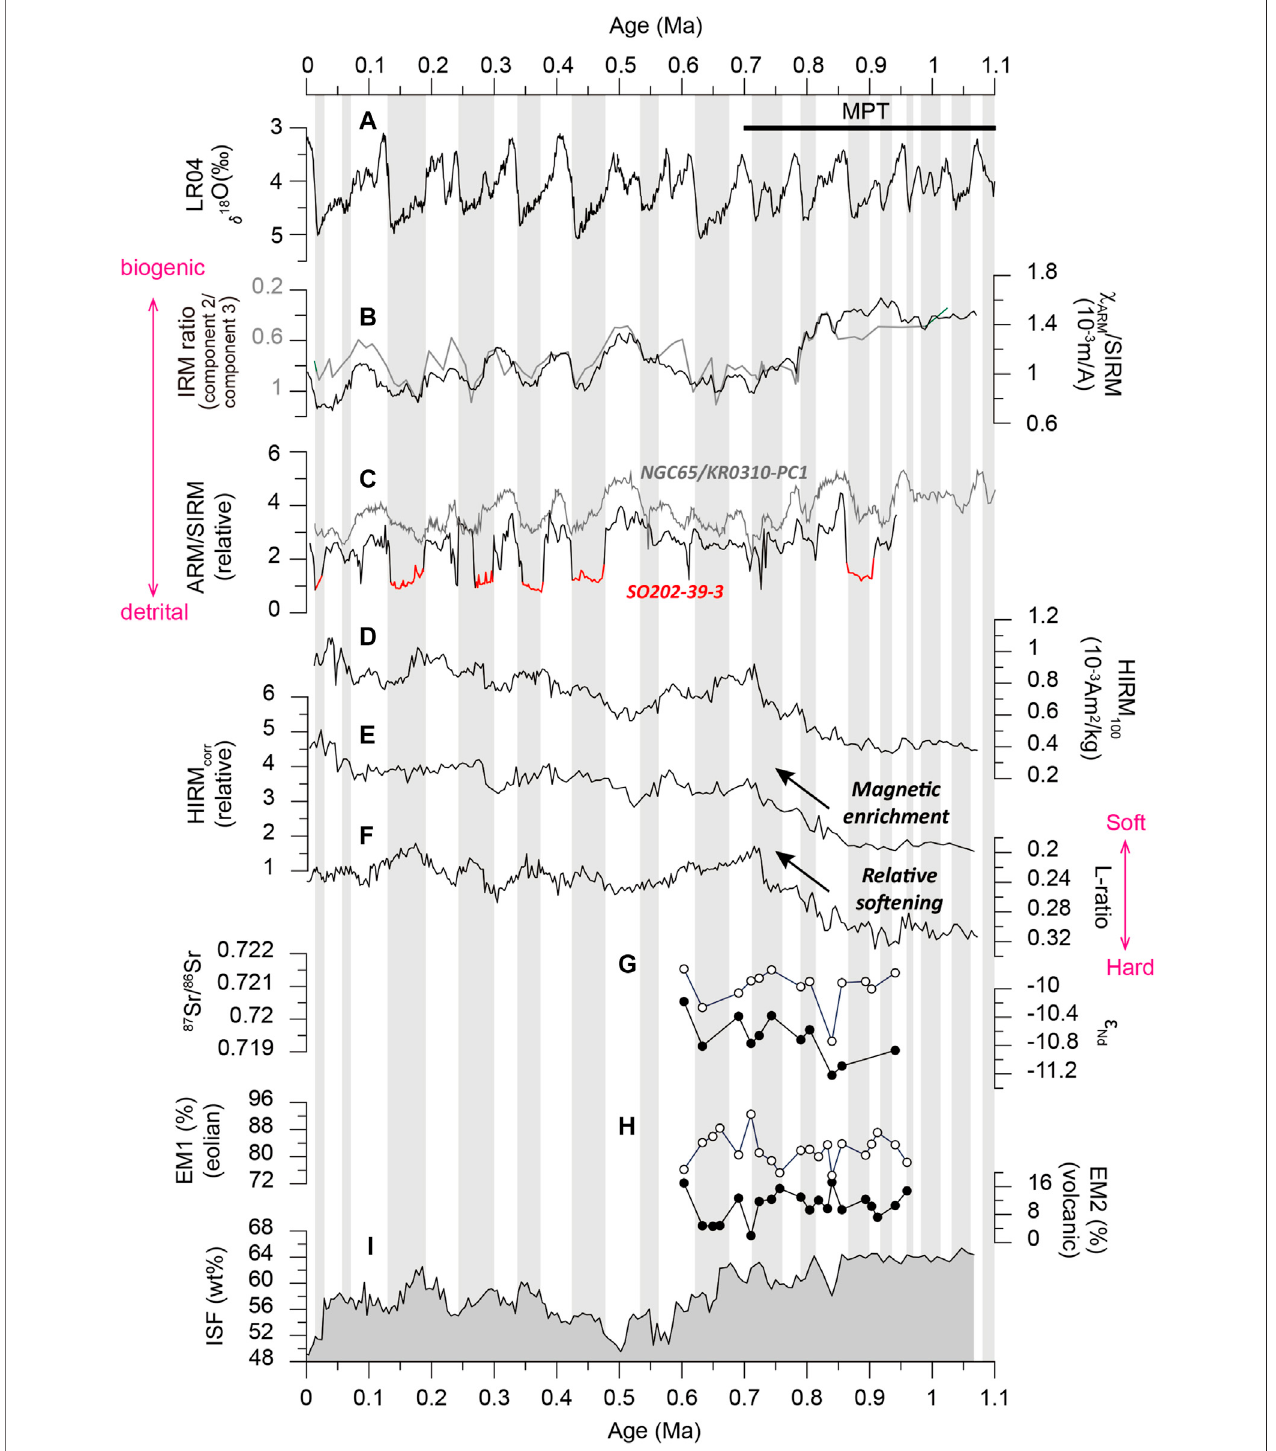
FIGURE5| Temporalvariationsofglobaloxygenisotopestack,magneticandgeochemicalcompositionsofNPGP1401-2Aandreferencecores. (A) LR04(Lisiecki andRaymo,2005); (B) RatiosofanhystereticremanentsusceptibilitytoSIRM( χ ARM /SIRM)(Shinetal.,2019)andIRMcomponents(Component2and3); (C) ARM/SIRM of reference cores (NGC65/KR0310-PC1 and SO202-39-3; Figure 1 ); (D) HIRM 100 ; (E) HIRM corr (corrected HIRM 100 for the non-terrigenous fraction calculated by HIRM corr (cid:1) HIRM 100 /(100 — watercontent%)/inorganicsilicatefraction(ISF%); (F) L-ratio; (G) 87 Sr/ 88 Sr(whitedots)and ε Nd (blackdots)values(Leeetal.,2019); (H) the major end-members, EM1 (white dots) EM2 (black dots), from grain size analysis (Lee et al., 2019); (I) ISF content (wt%). The MPT is marked at the top (1.2 – 0.7 Ma; Clark et al., 2006). Red in (C) presents intervals of post-depositional alteration.